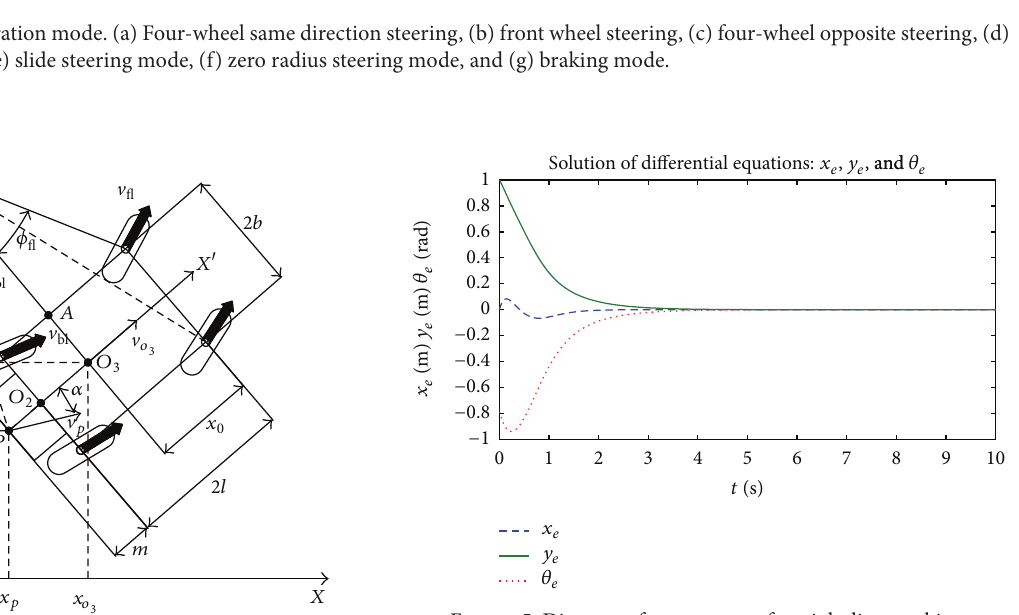
The robot’s initial position was 𝑝(0) = (−0.5, 0.5, 𝜋/2) 𝑇 and the initial position of expected path was 𝑅(0) = (0, 1, 0) 𝑇 .